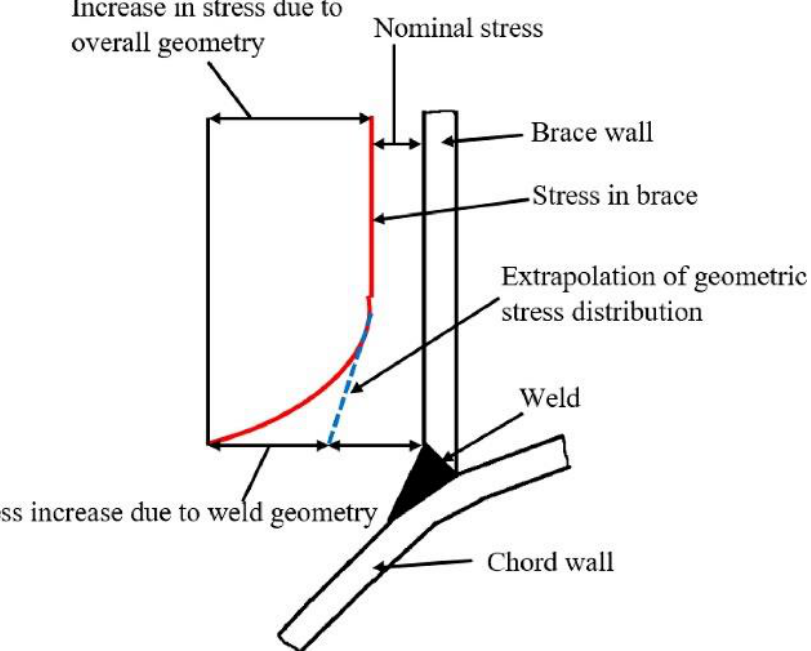
Figure 3. Stress distribution in typical tubular joints (no permission required, under CC BY-NC-ND license) [1]. license)